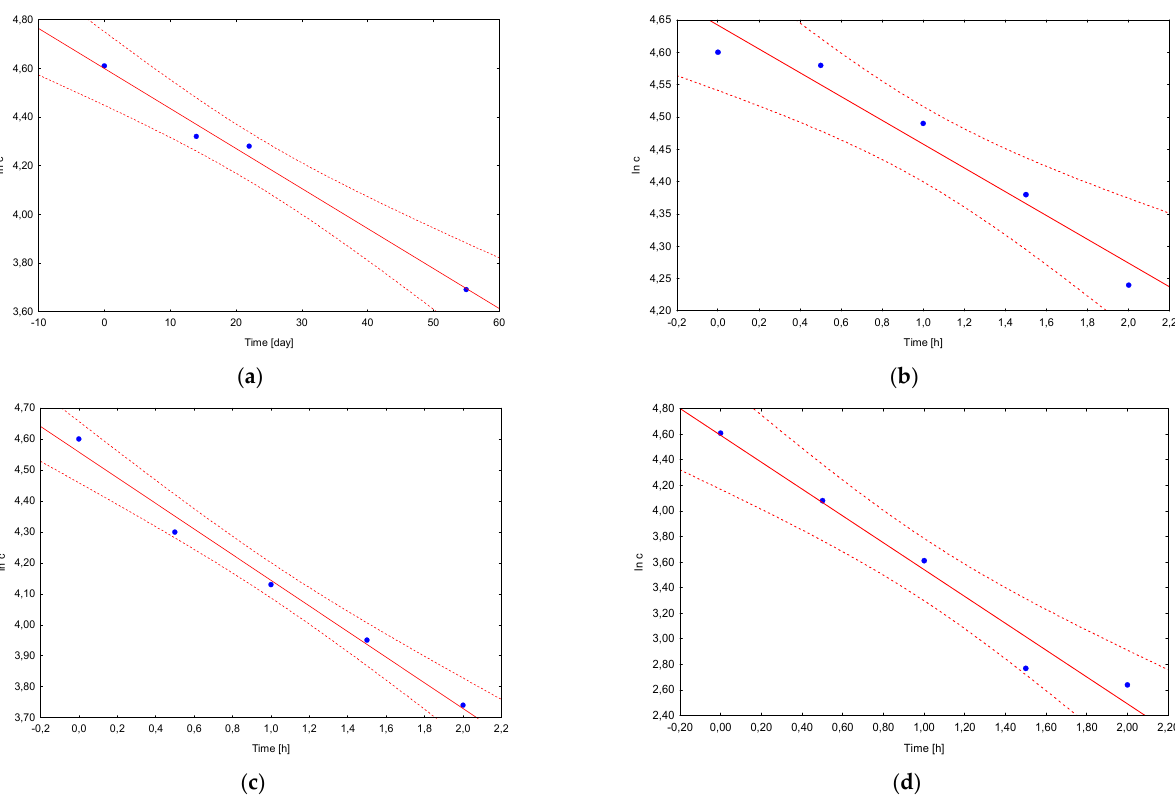
Figure 5. Selected graphs showing the degradation process of cefepime according to the first-order kinetics, ( a ) CEF at 4 °C, ( b ) CEF at 60 °C, ( c ) CEF, EST, and ( d ) CALC at 80 °C.